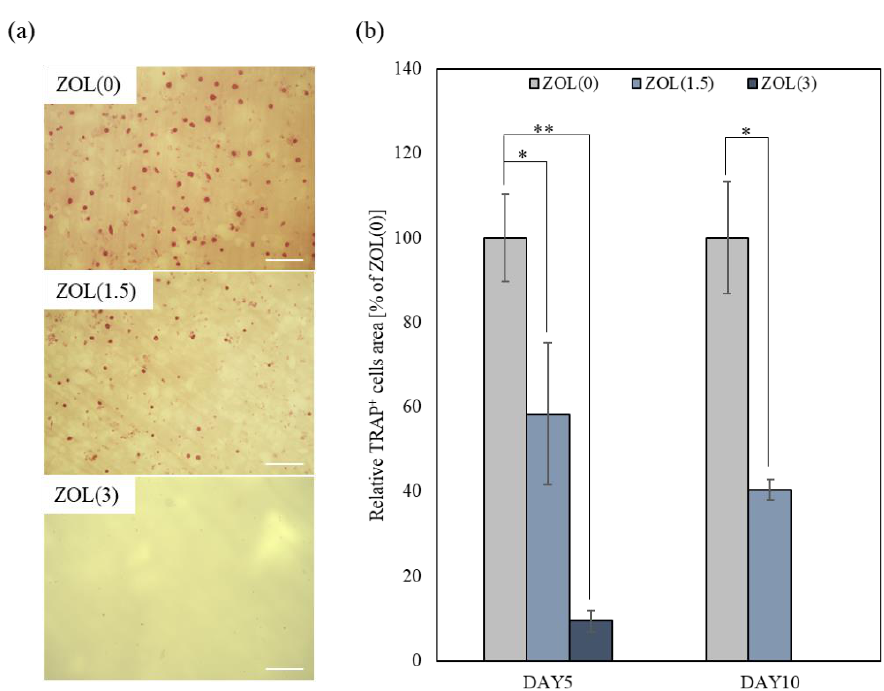
Figure 7. Effect of bound-ZOL for mice bone marrow stromal cells (mBMSCs) differentiation. mBMSCs were cultured on each ZOL/β-TCP disc for 5, 10 days (DAY5, 10). ( a ) Morphological observation of mBMSCs at days 5 and 10. mBMSCs were stained with Alexa Flour ® 488-labeled phalloidin for F-actin (green) and 4’,6-diamidino-2-phenylindole (DAPI) for nuclei (blue) and observed with fluorescence microscopy. White arrows; osteoclasts (cell with more than 2 nuclei), scale bars; 100 μm. ( b ) Relative osteoclasts area and ( c ) cell size of osteoclasts were analyzed by image analyzer. Error bars indicate standard deviation of the mean. The asterisks show * p < 0.05, ** p < 0.01 as compared with ZOL(0) by Student’s t -test.